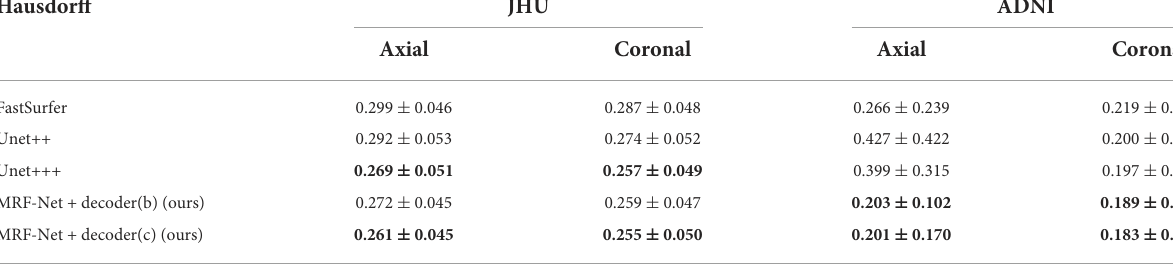
TABLE 4 Average hausdorff distance score across the axial and coronal segmentation